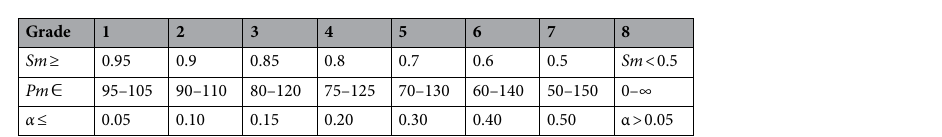
Table 1. TCM similarity grades criteria based on